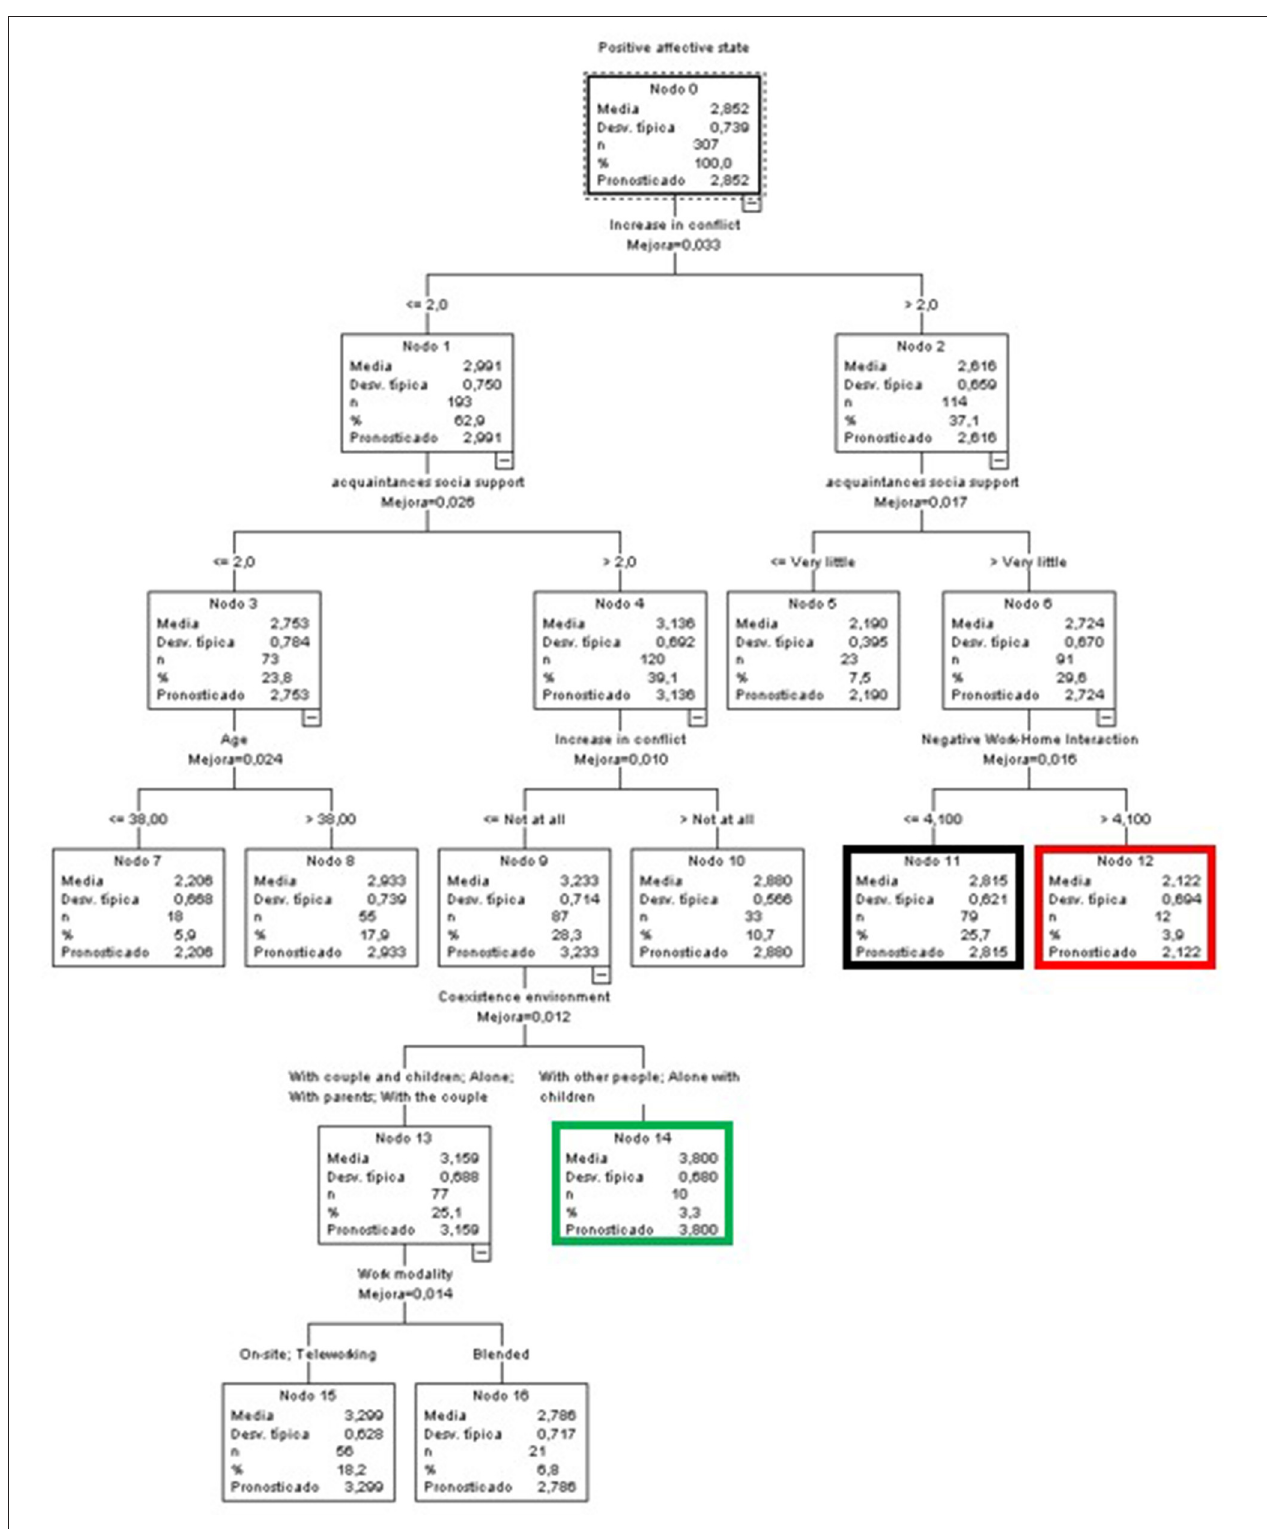
FIGURE 11 | Classificatory tree of positive affective states (A&S).